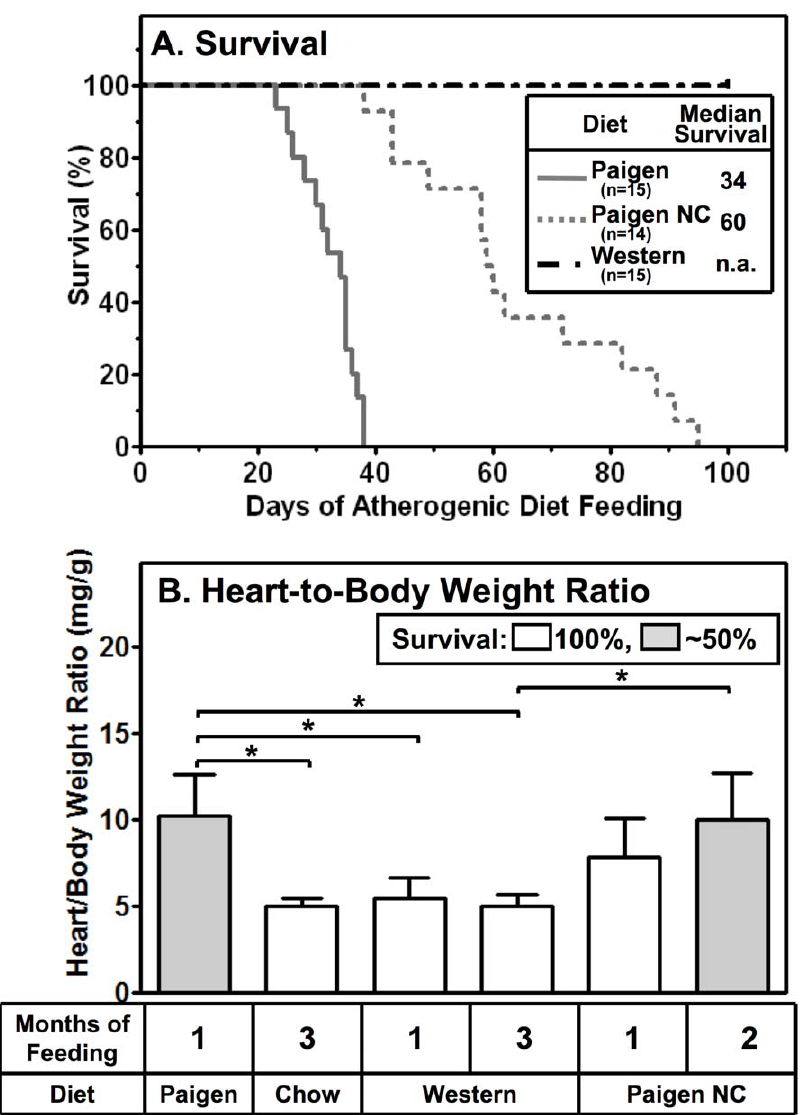
Figure 2. Effects of atherogenic diets on survival (A) and heart-to-body weight ratios (B) of HypoE mice. Mice were housed in groups with mixed genotypes (HypoE and one or more SRBI + / 2 ApoeR61 h/h littermates per group, 4–5/cage) and, beginning at two months of age were switched from a normal chow diet to the indicated atherogenic diets. The data shown include only the HypoE mice. A Kaplan-Meier survival curves. Mice were fed either Paigen (gray solid line, n=15), Paigen NC (gray dotted line, n=14), or Western (black dashed line, n=15) diets. B Heart-to-body weight ratios. For the indicated times (1–3 months), mice were fed the Paigen (n=14), chow (n=8), Western (n=5 (1 month), n=4 (3 months)), or Paigen NC (n=6 (1 month), n=4 (2 months)) diets. Gray and white bars represent those populations in which approximately 50% or 100% of the animals survived after the indicated times of feeding. Data are means 6 SD. Statistically significant differences were determined by Kruskal-Wallis tests followed by the Dunn’s multiple comparison post-test. *p ,